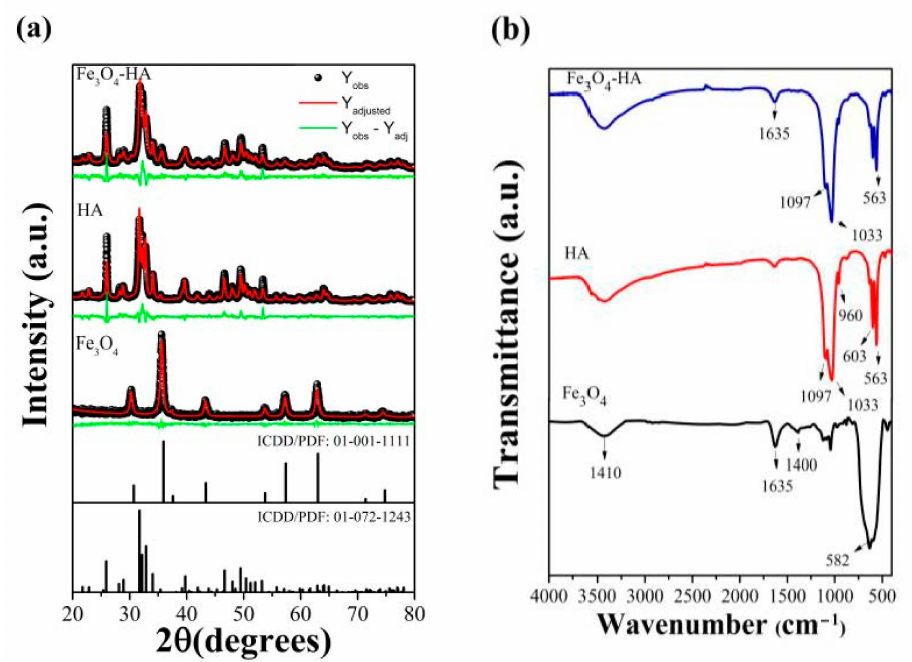
Figure 2. ( a ) X-ray diffraction (XRD) pattern of the Fe 3 O 4 , HA, and Fe 3 O 4 -HA; ( b ) Fourier-transform infrared (FTIR) spectra of the respective samples. Table 1. X-ray diffraction (XRD) patterns structural results through Rietveld refinement of HA, Fe 3 O 4 , and Fe 3 O 4 -HA samples.